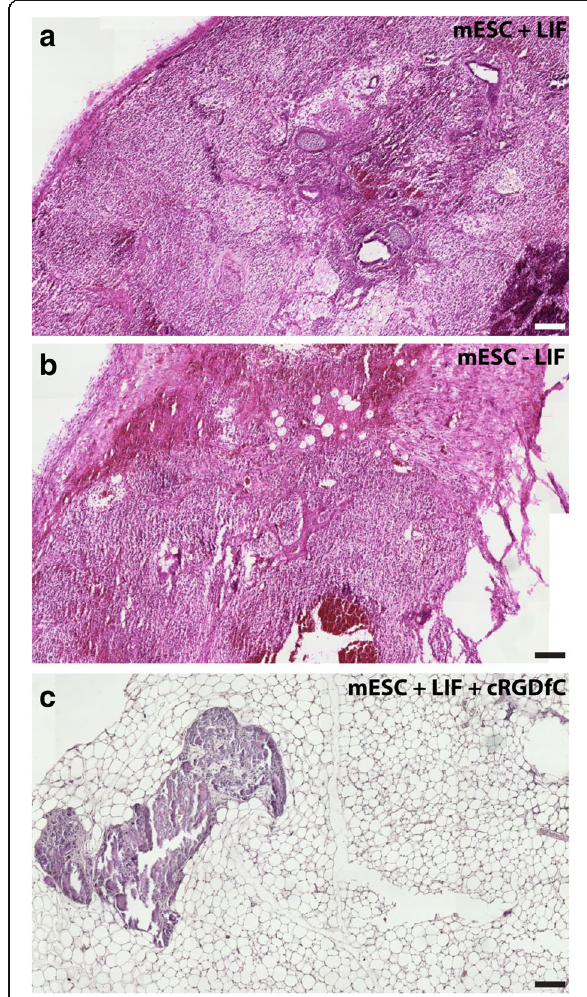
Fig. 5 Teratoma formation in SCID mice. Undifferentiated mESCs cultured in the presence of LIF generated teratomas in all (4/4) mice injected ( a ). mESCs cultured in the absence LIF for 24 h still produced teratomas in all (4/4) mice injected ( b ). When cRGDfC was supplemented to mESCs cultured in the presence of LIF, no teratomas (0/4) were observed, however one mouse (1/4) did present with a growth containing fat tissue ( c ). In the absence of LIF, but in the presence of cRGDfC, no teratomas (0/4) or tissue growths of any type were observed. Scale bar, 200 μ